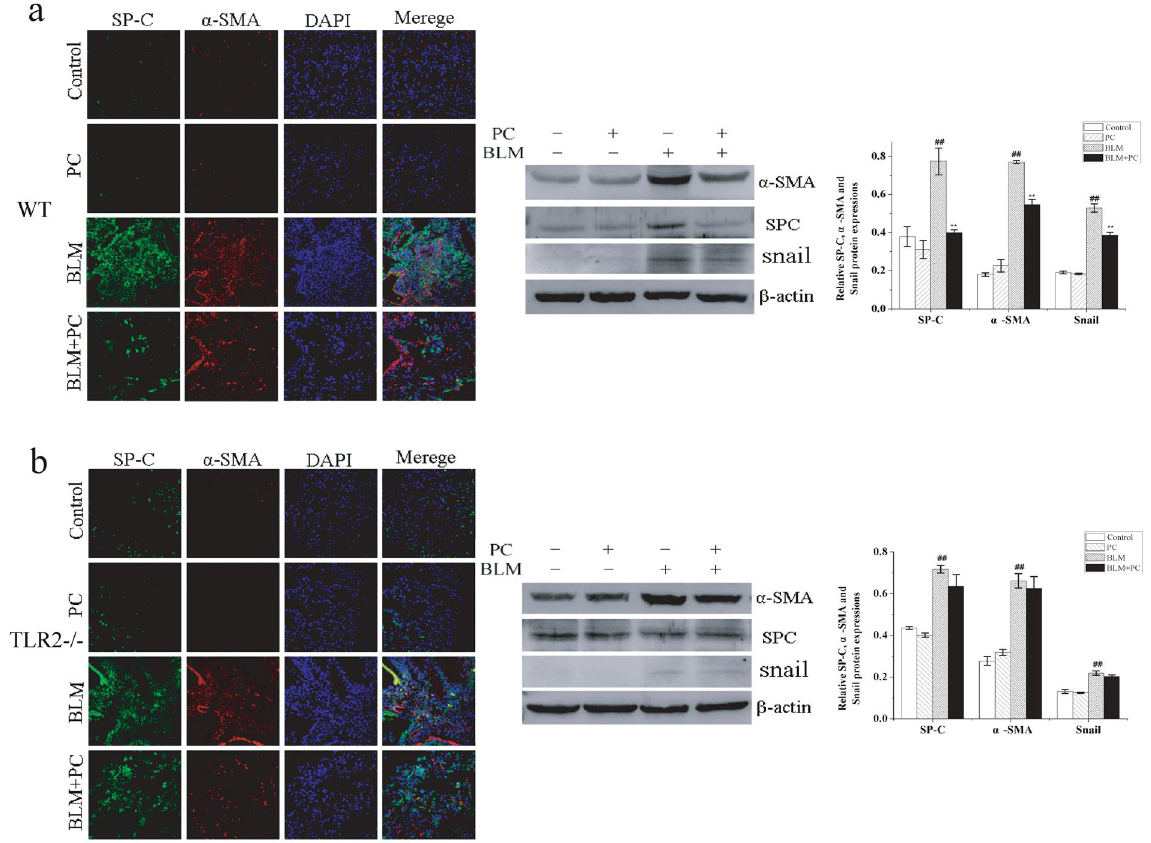
Figure 5. PC alleviated BLM-induced EMT phenomenon. After BLM treatment 28 days, Lung tissue of each group was stained with SP-C and α -SMA. ( a ) WT mice. ( b ) TLR2 − / − mice. Fluorescent immunocytochemistry stained for SP-C (green) and α -SMA (red). Images were visualised under a confocal microscope. Original magnification (400 × ). SP-C, α -SMA and Snail were analyzed by western blot. Data were expressed as mean ± SEM. ## p < 0.01 compared with the control group, ** p < 0.01 compared with the BLM group. aa p < 0.01 compared with WT mice.